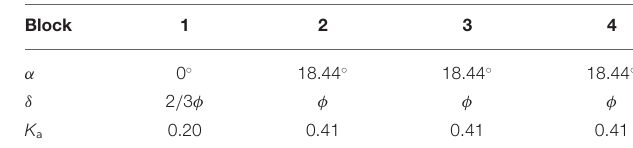
TABLE 2 | Active soil pressure coefficient K a at each block of the example wall for global equilibrium, including the angle α of the fictitious back plane and the angle of friction δ of each